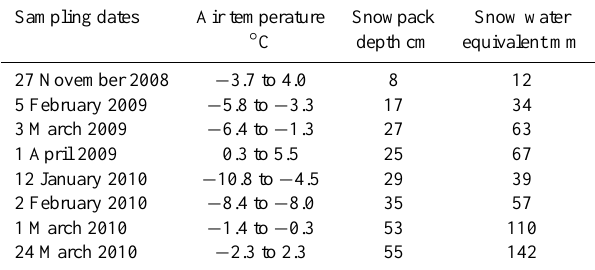
Table 1. Sampling dates, min–max range of air temperatures, snow- pack depths and snow water equivalents during winters 2008–2009 and